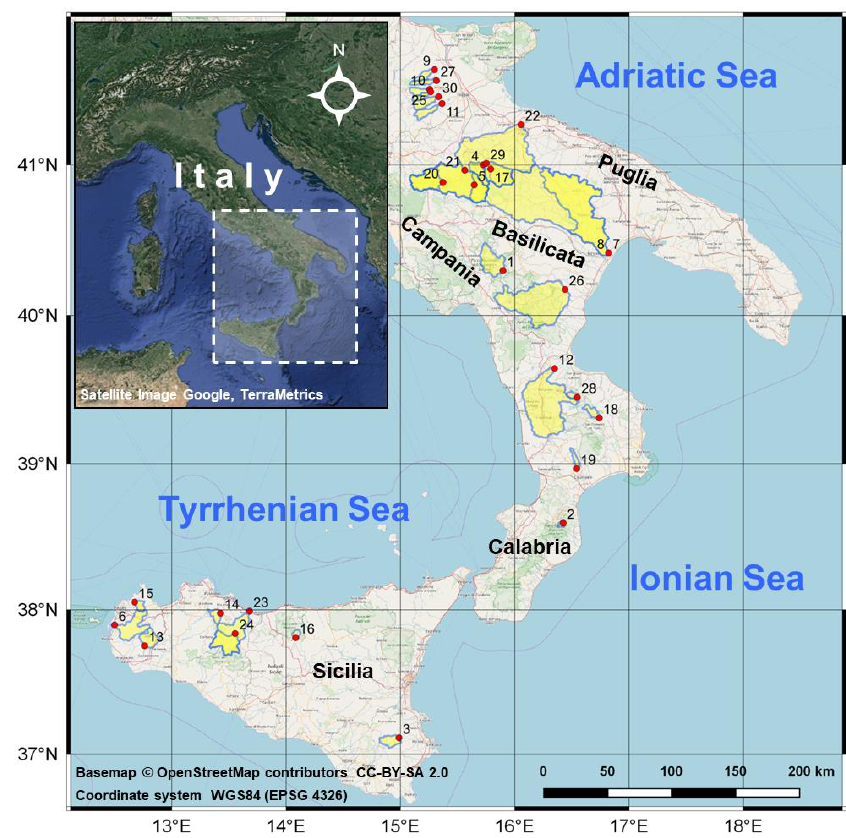
Figure 1. Geographic location of the selected river catchments. Red dots indicate SY gauging stations, numbered in alphabetical order (see Table 1).